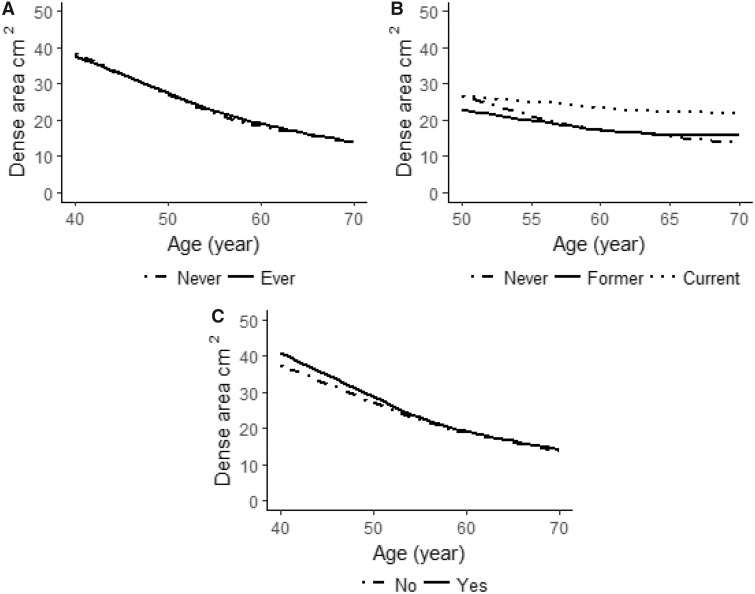
Mean baseline mammographic dense area (cm2) as a function of age at mammography screening and A) oral contraceptive use (never, ever), B) menopausal hormone therapy (MHT) use in postmenopausal women (never, former, current) (because only a few postmenopausal women currently used MHT and were <50 years old [n = 42], we included only postmenopausal women ≥50 years old in this graph), and C) family history of breast cancer (yes, no) at study entry.